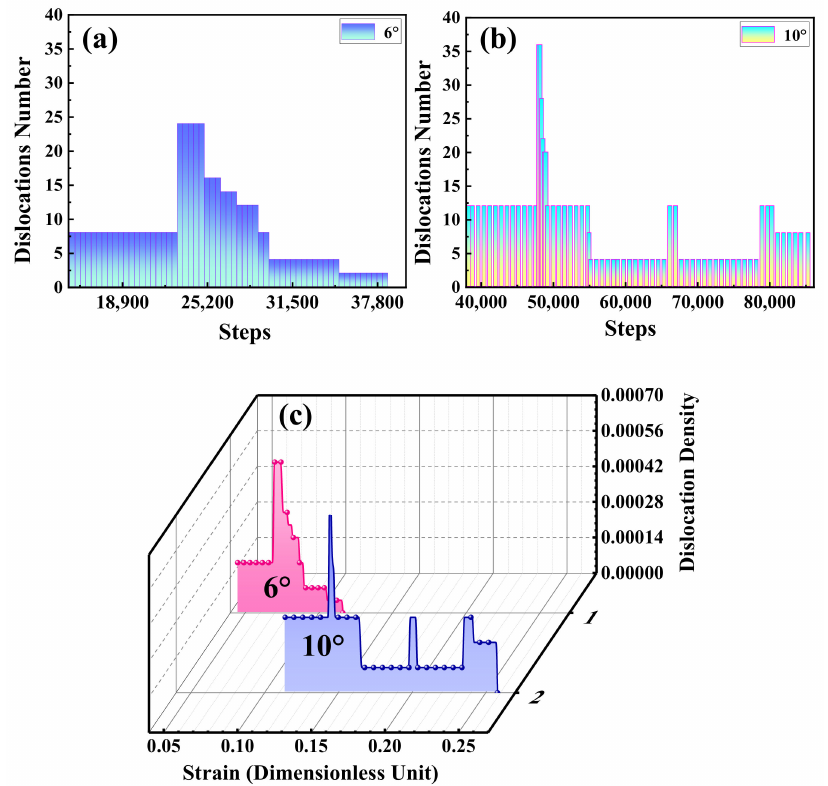
Figure 10. ( a , b ) are, respectively, the number of dislocations at 6 ◦ and 10 ◦ . ( c ) Stain and dislocation density at 6 ◦ and 10 ◦